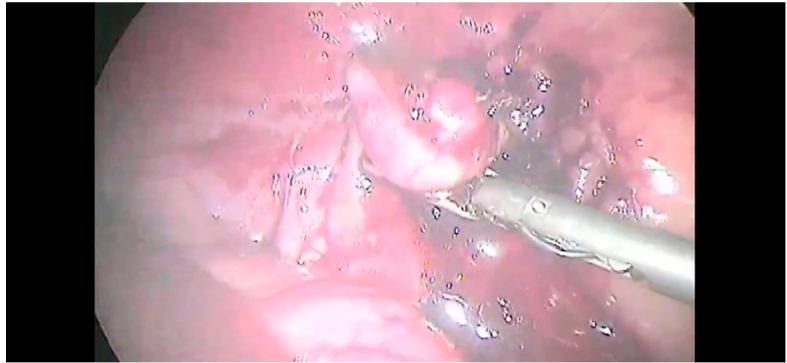
Figure 5. Complete dissection of the adrenal gland.